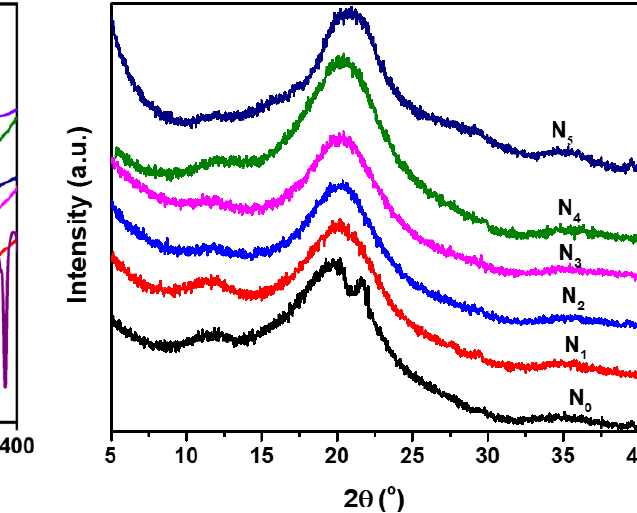
Figure 8: XRD patterns of the cross-linking agent treated cellulose scaffolds. N 0 -N 5 corresponding to the cellulose scaffolds treated with 0, 0.2, 0.4, 0.6, 0.8, 1.0 wt% MBA solutions, respectively crease of hydrogen bonds, and hence decreased the crys-